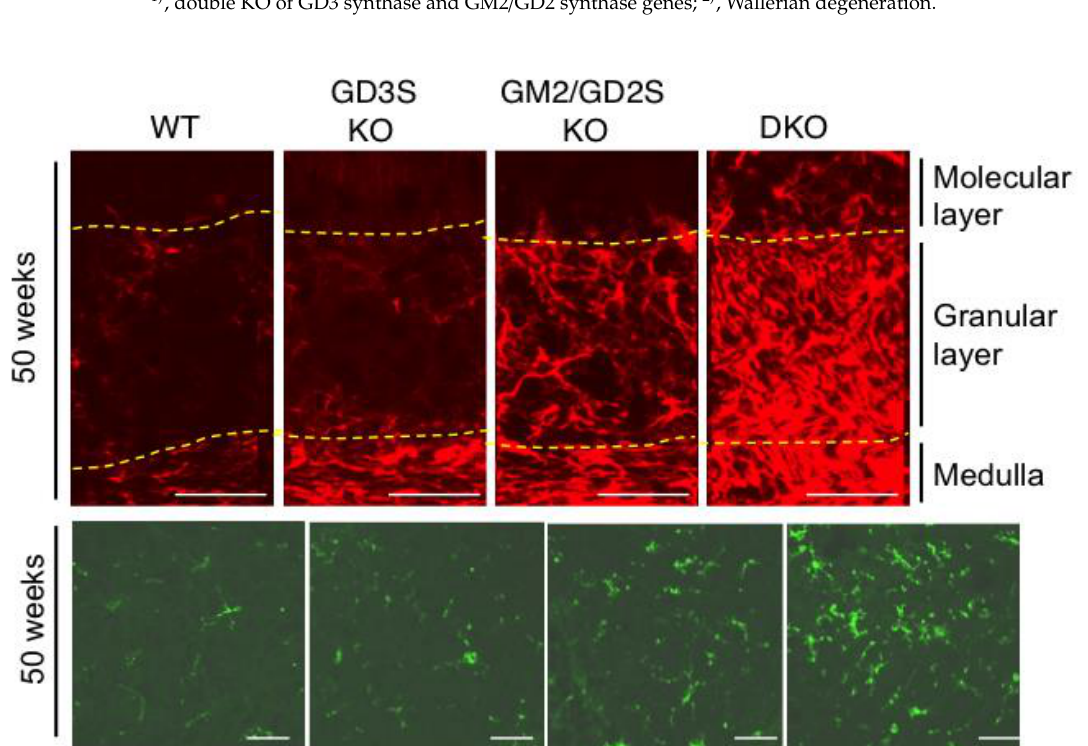
Figure 3. Immunohistochemistry of GFAP-positive astrocytes and F4/80-positive microglia. Cerebella from 50-week-old mice were analyzed by anti-glial fibrillary acidic protein (GFAP) antibody and Alexa Fluor 555-conjugated anti-mouse IgG1, and anti-mouse F4/80 and Alexa Fluor 488-conjugated anti-rat IgG. Marked gliosis was found in ganglioside synthase gene KO mice. GFAP-positive cells were increased (upper, red), and F4/80-positive cells (lower, green) accumulated in cerebella, indicating astrocytes and microglia, respectively. Scale bar, 50 µm in both panels. Borders between layers of the cerebellum indicated based on Hematoxylin-Eosin staining of serial sections. .